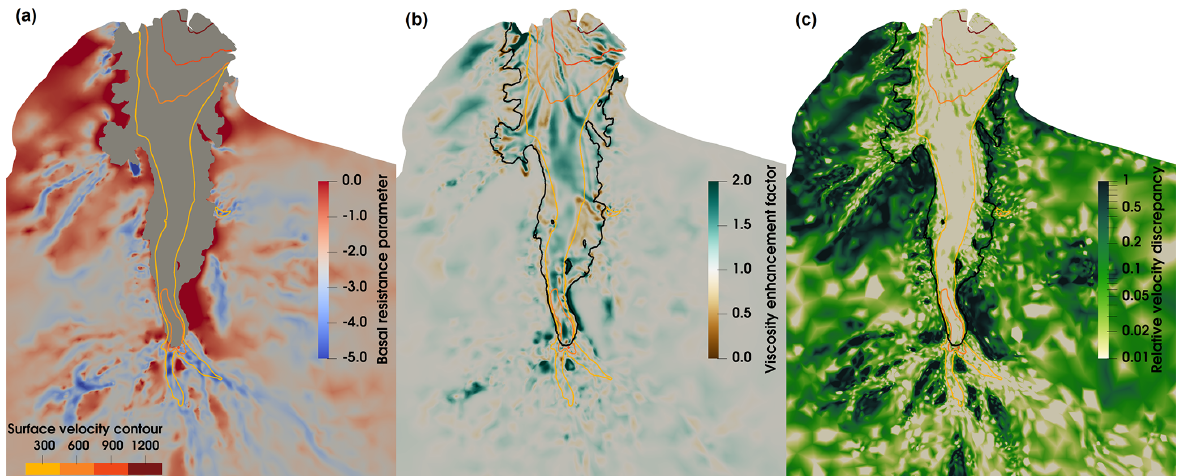
Figure 3. The optimised basal resistance parameter β (a) , viscosity enhancement factor E η (b) and relative surface horizontal velocity discrepancy (c) for the LAGS in the final state of experiment E3 of Gladstone and Wang (2022). The relative surface velocity discrepancy is the magnitude of the surface horizontal velocity difference between observations (Rignot et al., 2017) and simulations as a fraction of the observations. The four contours represent the surface velocity of 300, 600, 900 and 1200ma − 1 respectively, extracted from the final state of experiment E3. The black line in (b) and (c) represents the grounding line from BedMachine Antarctica (Morlighem, 2019; Morlighem et al., 2020).